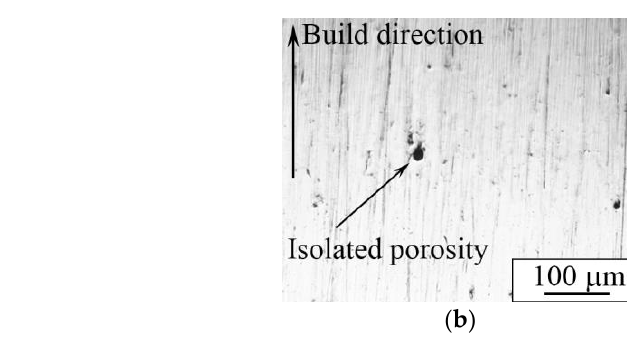
Figure 14. Optical image of ( a ) porous and ( b ) dense LPBF samples’ transverse section.